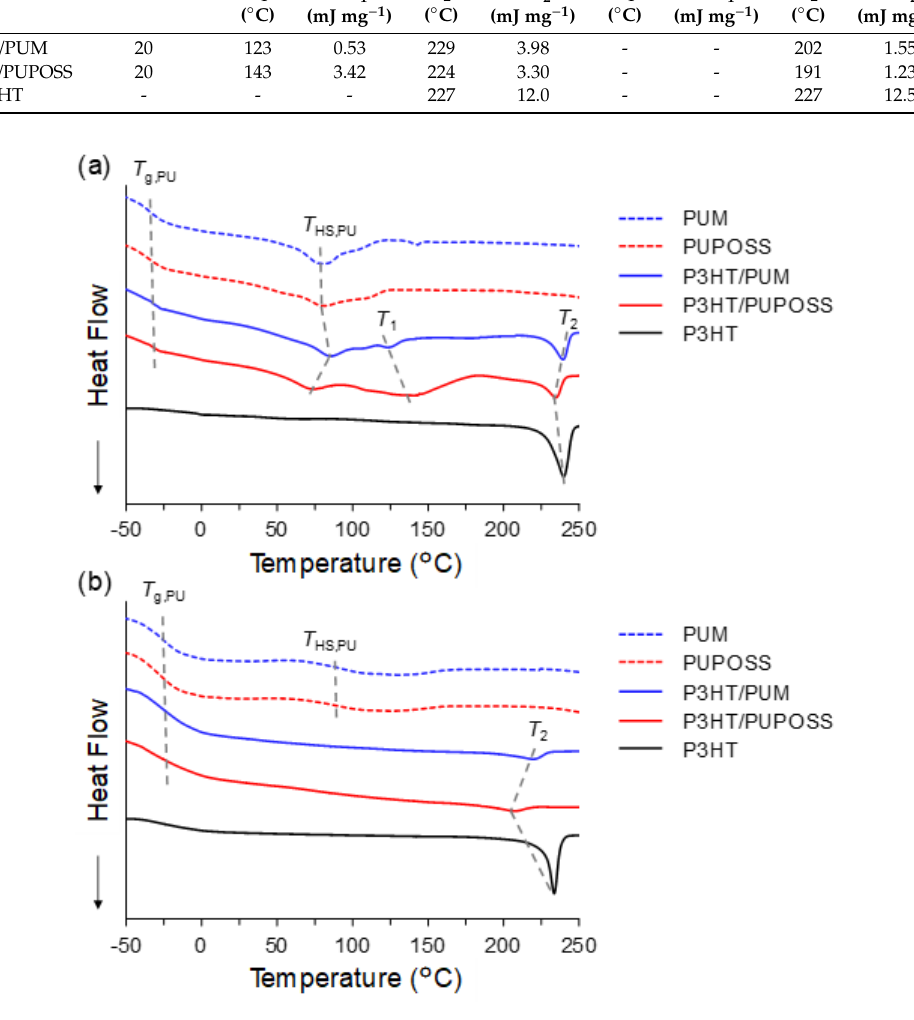
Figure 2. Differential scanning calorimetry curves of each film at ( a ) first and ( b ) second heating cycles. Heating rate was 10 °C/min. The content of P3HT of P3HT/PUM and P3HT/PUPOSS was 20 wt %.